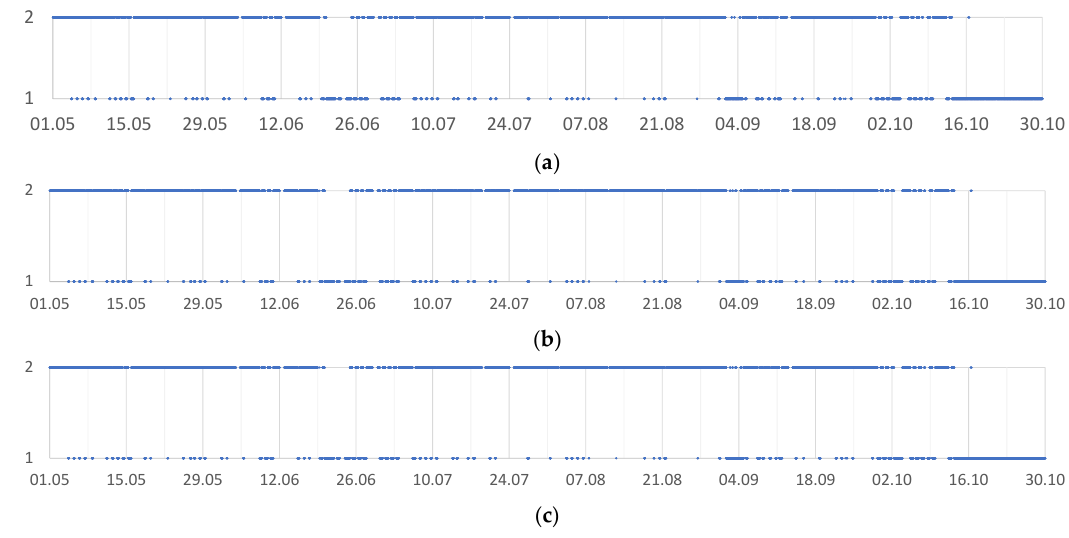
Figure 3. Results of cluster analysis for different input databases. ( a ) Database I: raw PQ data + Pphase , ( b ) Database II: ADI components separately + Psum , ( c ) Database III: ADI + Psum .